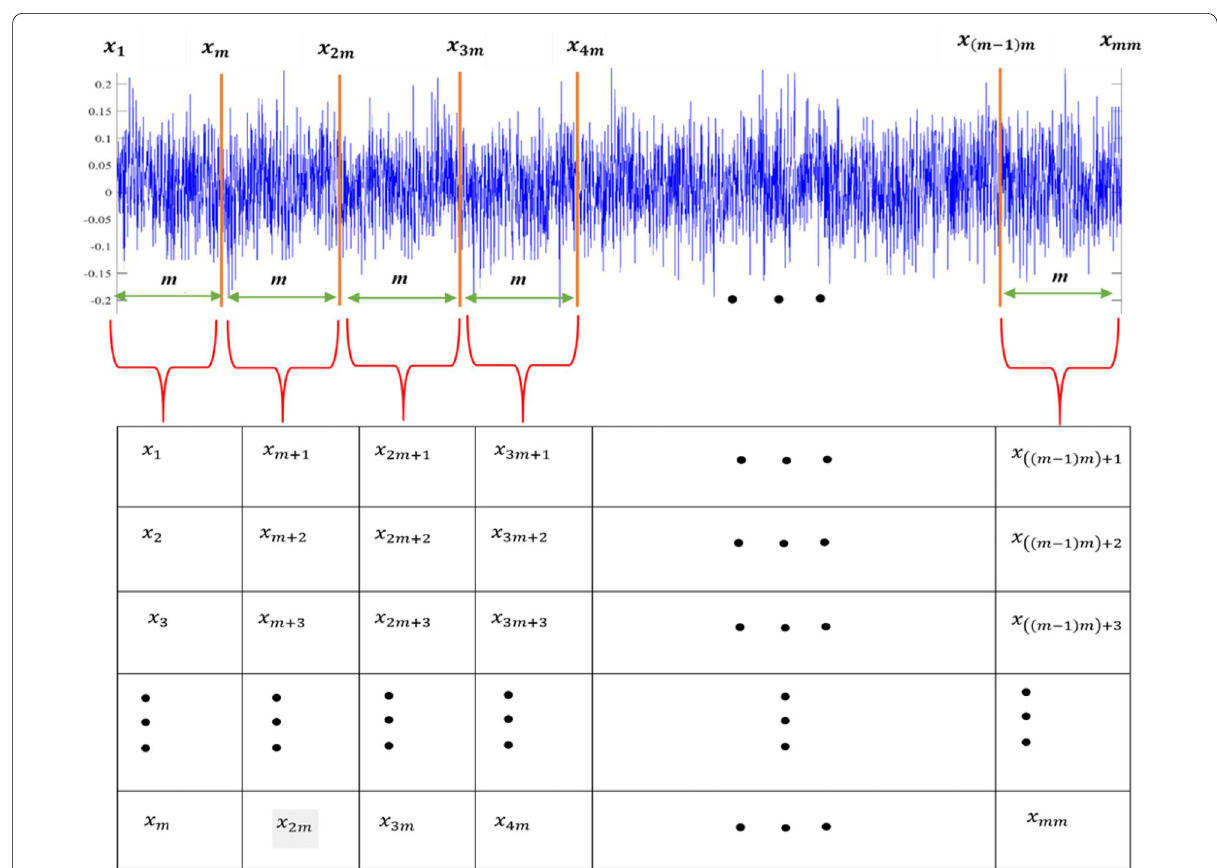
Figure 2 Conversion of 1-D vibration signal to 2-D vibration image